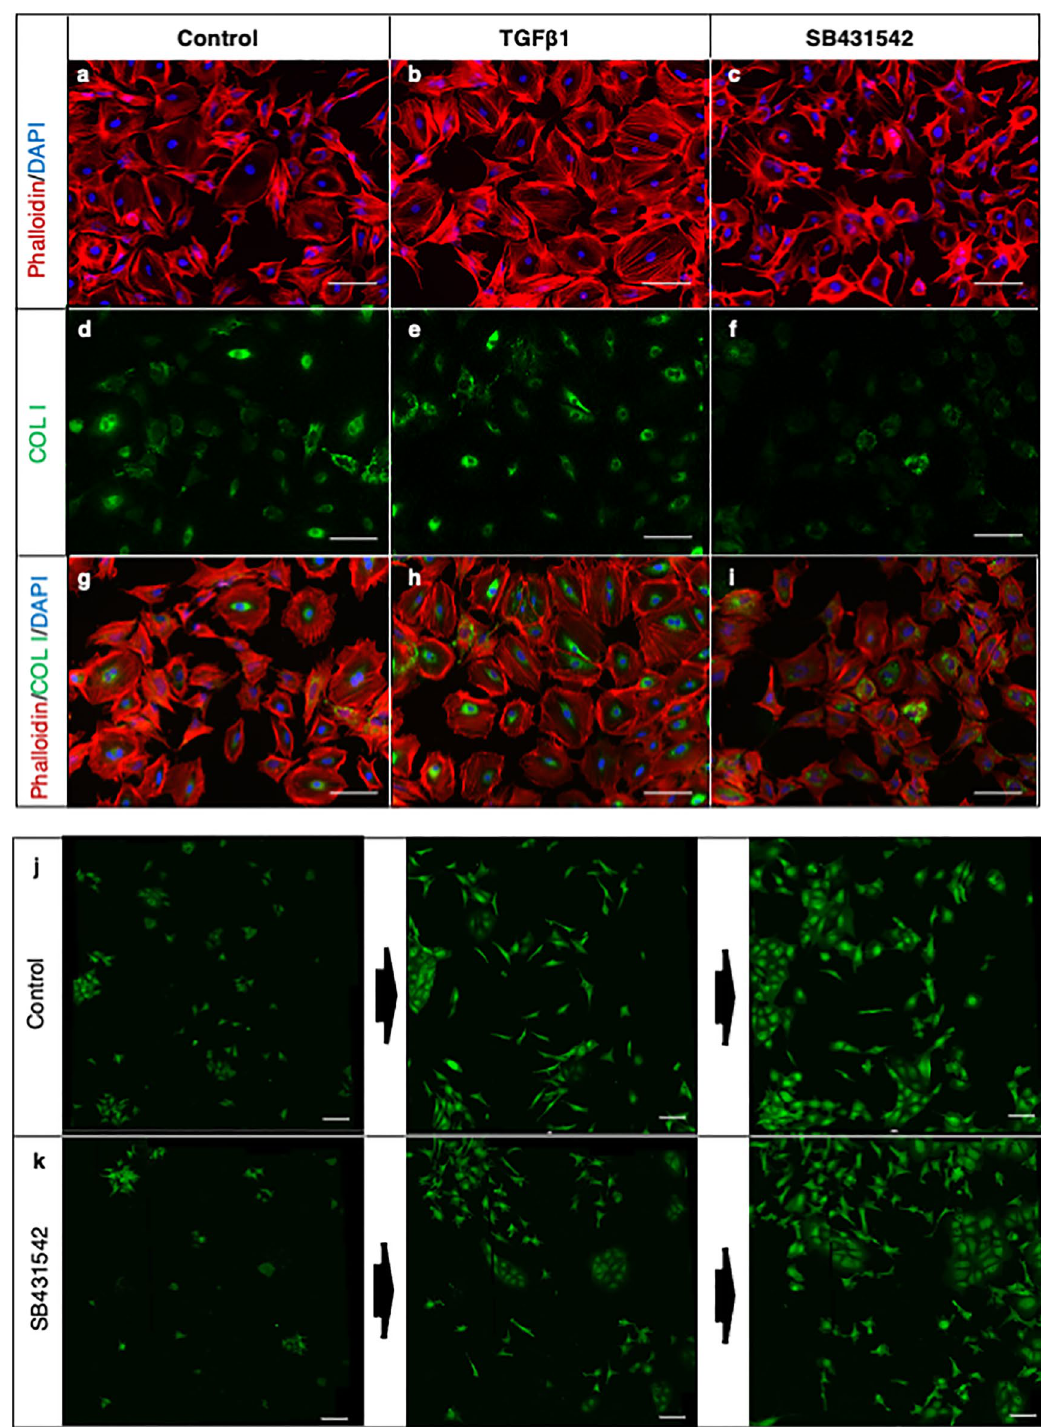
Figure 6. Effect of TGFβ signal on osteogenic-induced iPSCs on type I collagen gel. The whole cell fraction of osteogenic-induced hiPSCs (414C2) was isolated at day 14 and cultured for 48 h in control medium ( a , d , g ) or medium supplemented with TGFβ1 (5 ng/mL) ( b , e , h ) or SB431542 (10 µM) ( c , f , i ). Cells were stained with Phalloidin (red) and DAPI (blue) ( a – c ) or antibody for COL I ( d – f ). ( g – i ) Merged images. Snapshots of the time-lapse imaging of isolated cells from days 1 to 3 cultured in control medium ( j ) or medium supplemented with SB431542 (10 µM) ( k ). Scale bars = 100